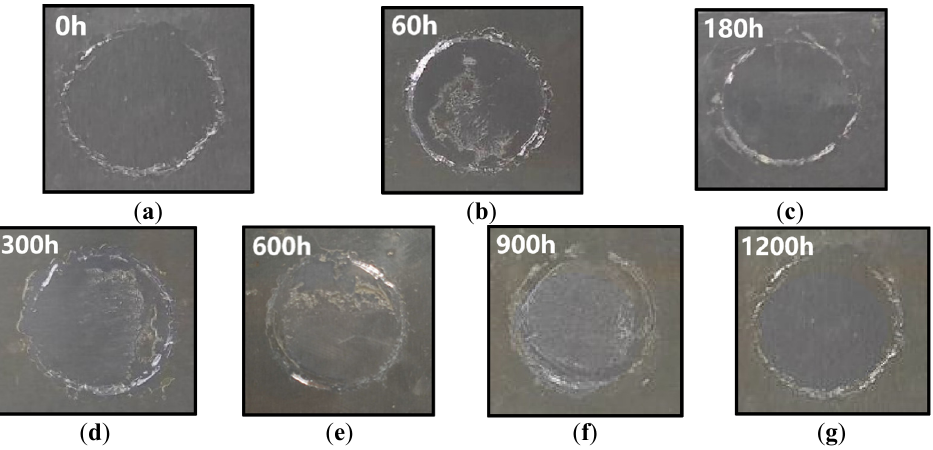
Figure 5. Samples after the pull-off test. ( a ) 0 h; ( b ) 60 h; ( c ) 180 h; ( d ) 300 h; ( e ) 600 h; ( f ) 900 h; ( g ) 1200 h